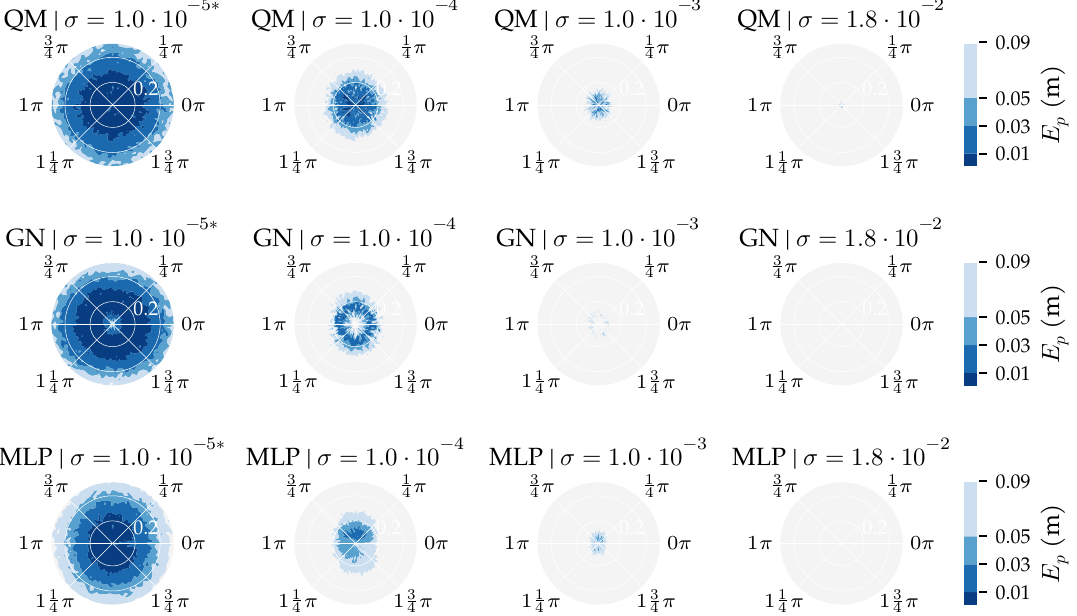
Figure A15. Polar contours of the median position error (Equation (4)) for QM, GN, and MLP using simulated sensors with higher velocity equivalent noise levels. These figures indicate how the movement direction ϕ and distance d of a source influence the error. The D s = 0.01 training and optimisation set and (x + y) sensor configuration were used. The values for σ = 1.0 × 10 − 5 ms − 1 are based on the D s = 0.01 condition in Analysis Method 1. The MLP was re-trained for each noise level. Both the MLP and GN used the optimal hyperparameter values from the D s = 0.01 condition of Analysis Method 1. The median position error was computed in 2 × 2 cm 2 cells. The sensors were equidistantly placed between x = ± 0.2